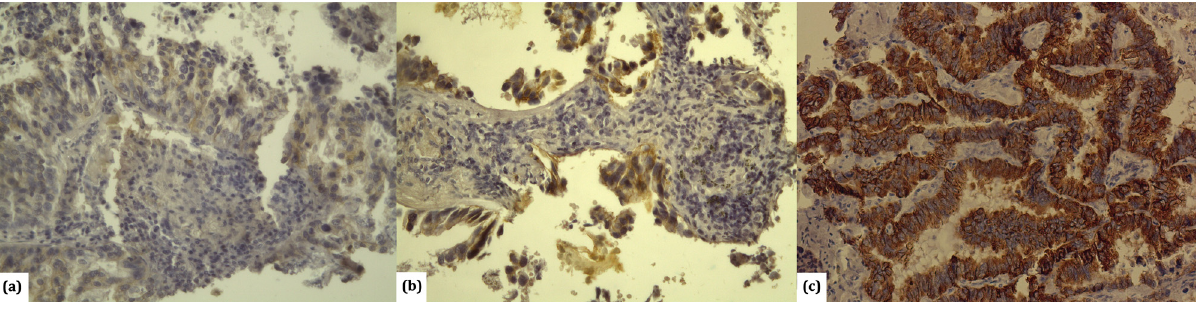
Figure 1: Immunohistochemical detection of HER - 2 antibody HercepTest, Dako in lung adenocarcinoma: ( a ) tumours with poor, incomplete membrane – negative 1 + (× 200 ) ; ( b ) tumours with strong, incomplete basolateral dying in more than 10% of tumour cells – positive 2 + (× 200 ) ; and ( c ) tumours with strong, complete membrane dying in more than 10% of tumour cells - positive 3 + (× 200 )